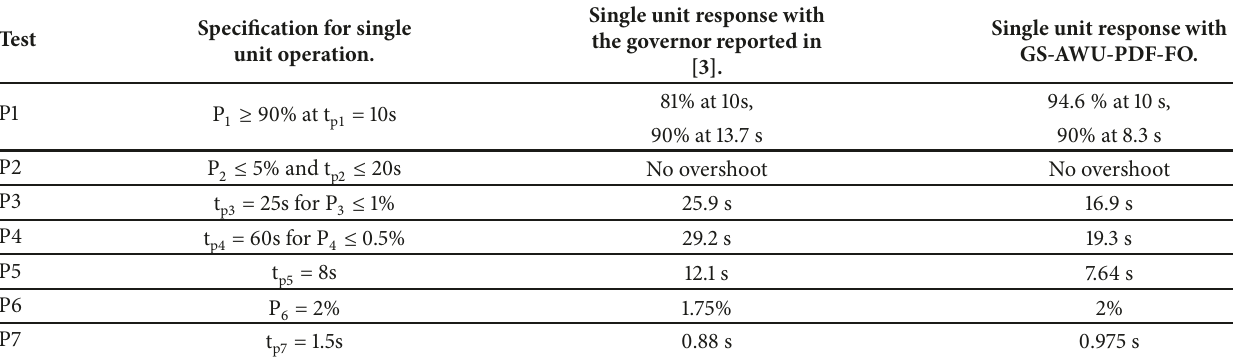
Table 1: Specification of step response for advanced control design at Dinorwig [1,